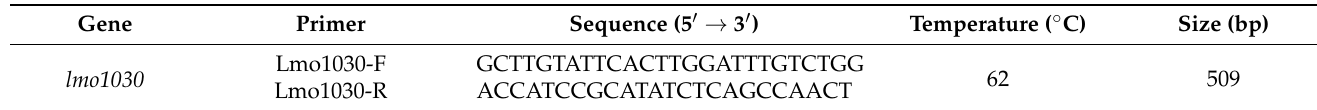
Table 5. The gene and primers used to identify strains of Listeria monocytogenes by PCR